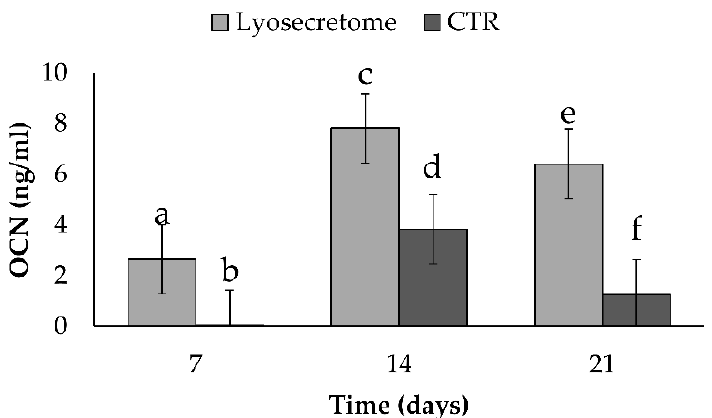
Figure 5. Osteocalcin concentration for Lyosecretome or CTR scaffolds cultured in osteogenic dif- ferentiation medium for 7, 14, and 21 days. Multifactor ANOVA (time and treatment, mean values ± LSD, n = 3) was used. Different letters (a,b,c,d,e,f) indicate a significant difference between the means ( p < 0.05), while the same letters indicate no significant difference between the means ( p > 0.05).